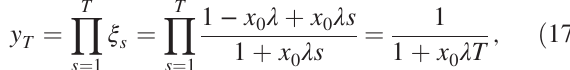
σ 2 σ KK ⊤ (cid:2) þ z 2 =m with λ w min min ¼ min ½